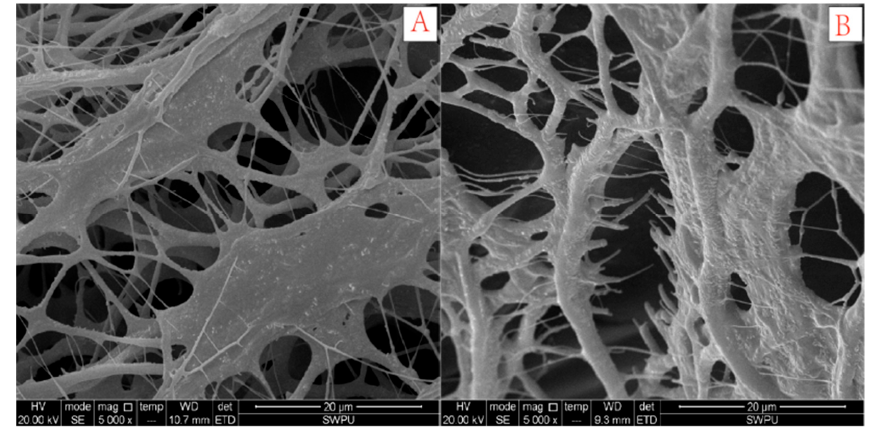
Figure 18. SEM images (×5000) of a 0.3 wt% DiPHAM aqueous solution with different concentrations of Mg 2+ ions ( A ) 1000 mg/L; ( B ) 3000 mg/L.